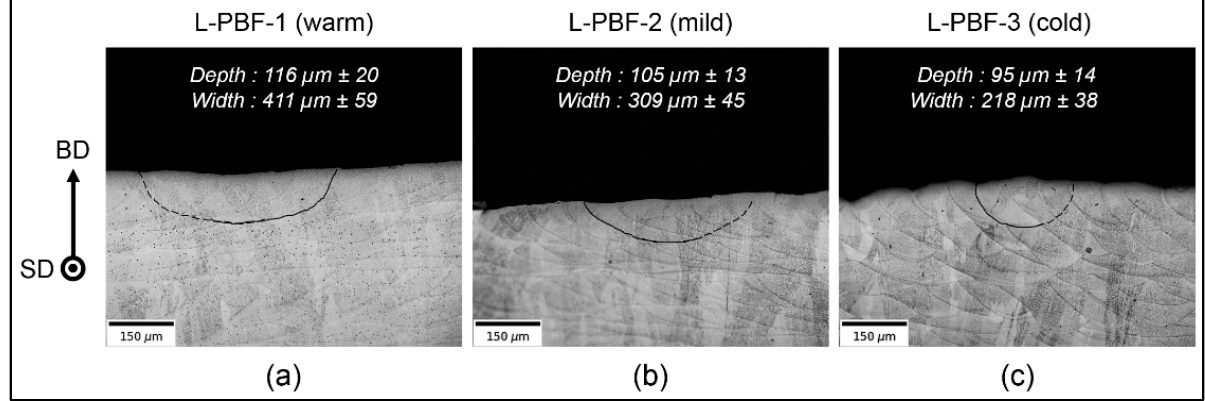
Figure 12. Etched micrographic cross-sections showing L-PBF beads for ( a ) warm, ( b ) mild, and ( c ) cold conditions, and allowing the measurement of the melt pool dimensions (depth and width) of the last layer. Here, SD indicates the scan direction of the last layer.